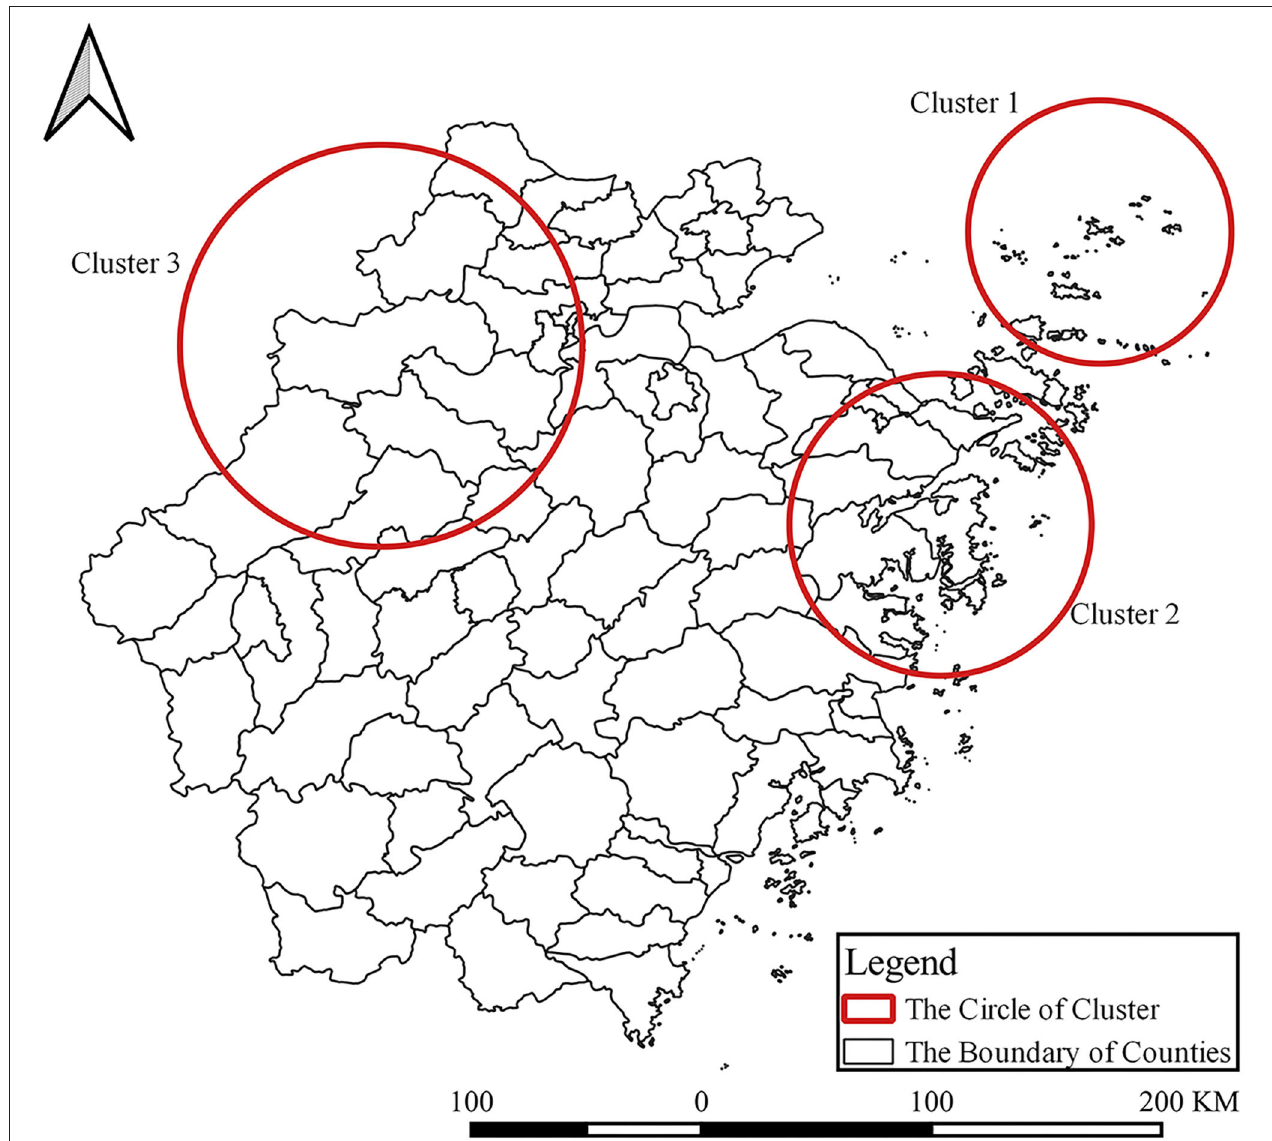
FIGURE 8 | Time-space clusters of SFTS cases at county level in Zhejiang Province from 2011 to